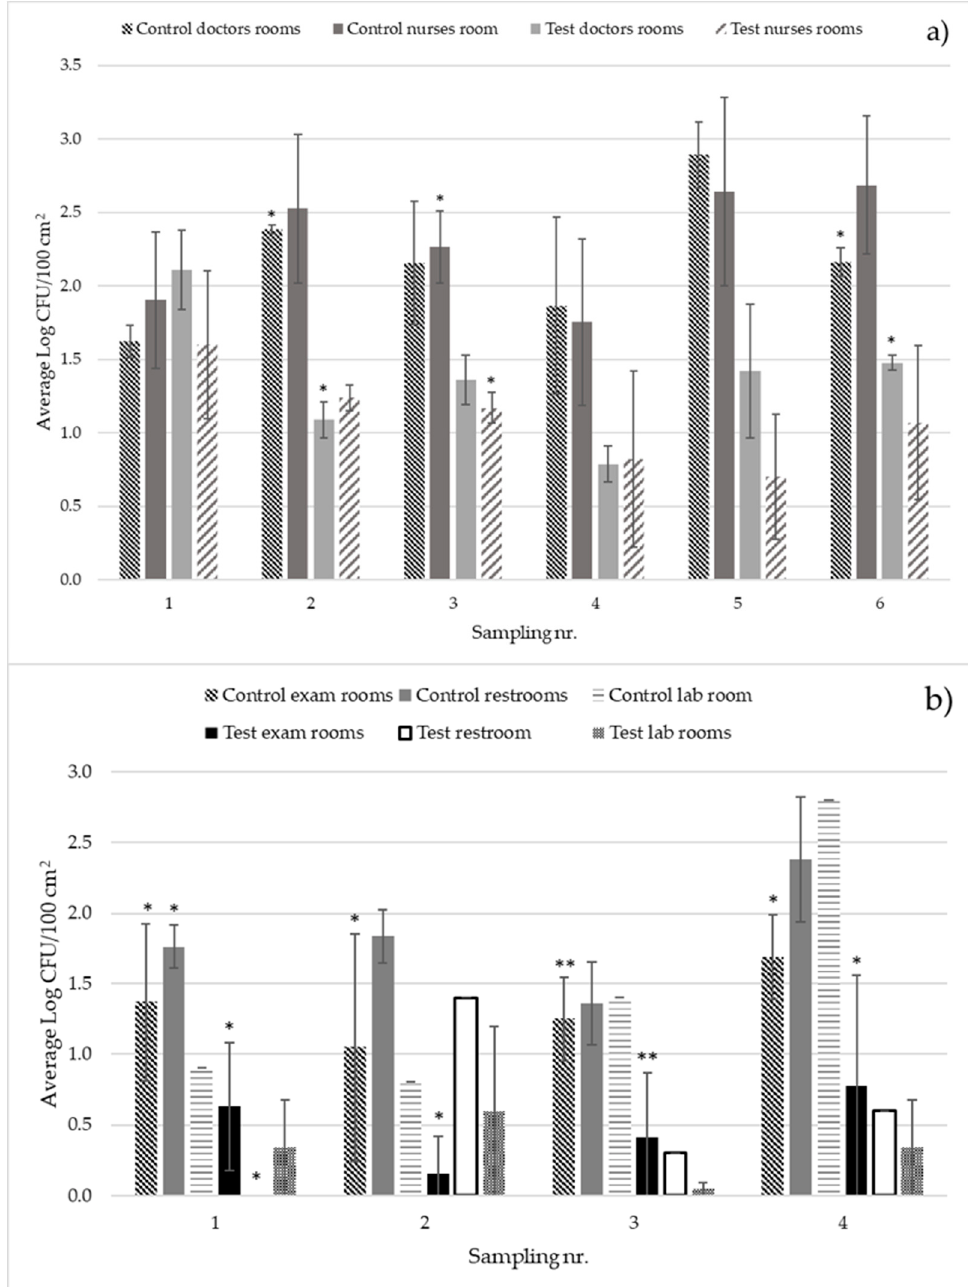
Figure 1. Averaged aerobic plate count presented as logarithmic transformed values (Log CFU / 100 cm 2 ) from copper-silver alloy coated (test) and reference (control) door handles installed at doctors’ and nurses’ rooms at FamilieLægerne Espergærde ( a ), and from copper-silver alloy coated (test) and reference (control) door handles installed at exam rooms, laboratory rooms and restrooms at Southwest Regional (SWR) Wound Care Center ( b ). Error bars indicate standard deviations among the aerobic plate count values of test and control door handles groups for each sampling. The statistical di ff erence among the di ff erent pair cases is indicated as * for p < 0.05 and ** for p < 0.01.